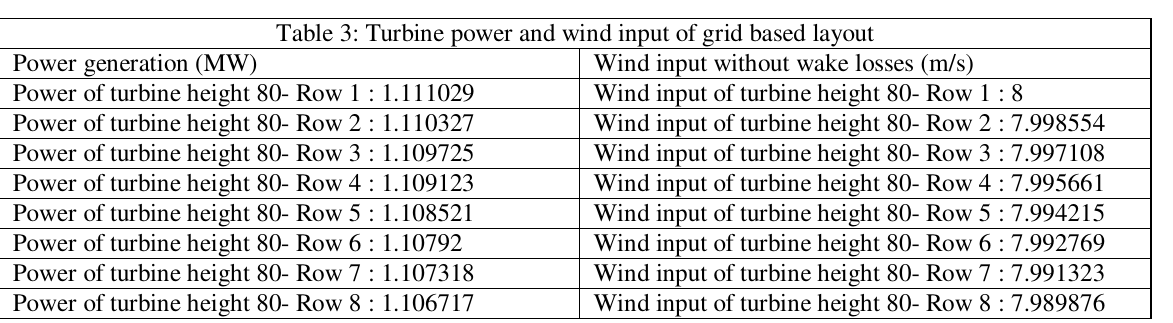
Table 3: Turbine power and wind input of grid based